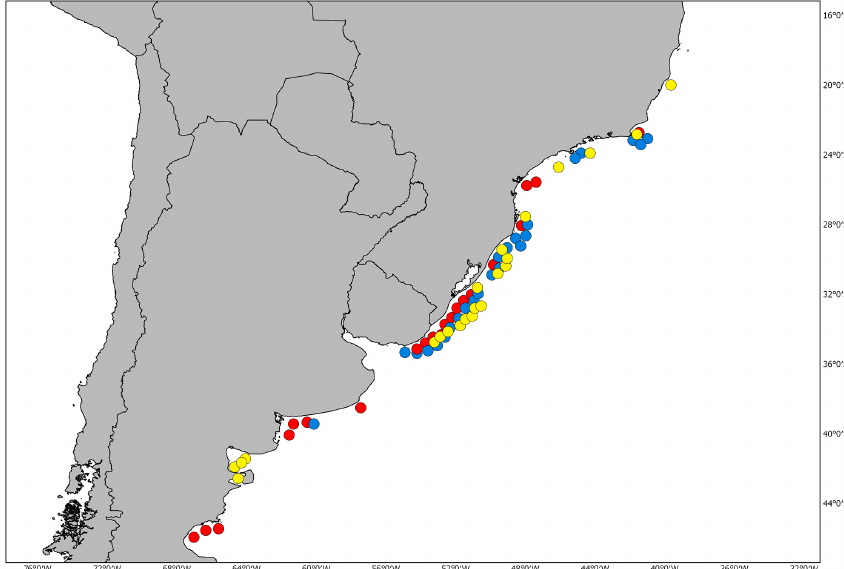
FIGURE 6 | Map showing the geographic distribution of species of Atlantoraja based on material examined in this study and literature; A. castelnaui (red), A. cyclophora (blue), and A. platana